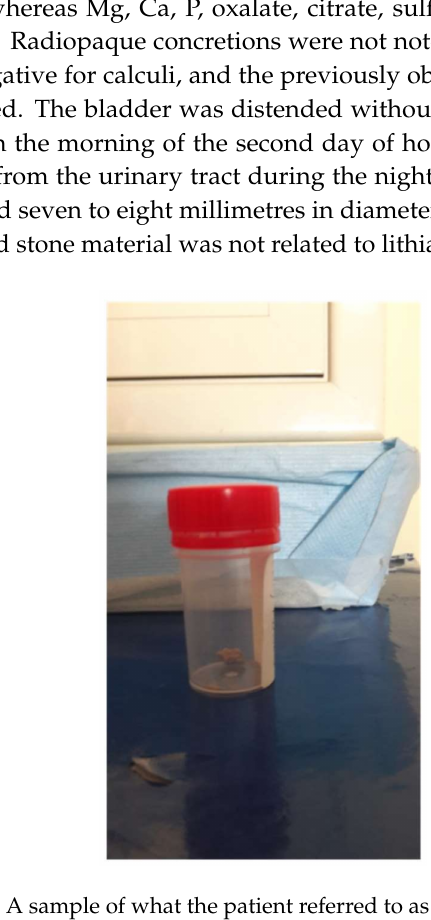
Figure 1. A sample of what the patient referred to as his urinary